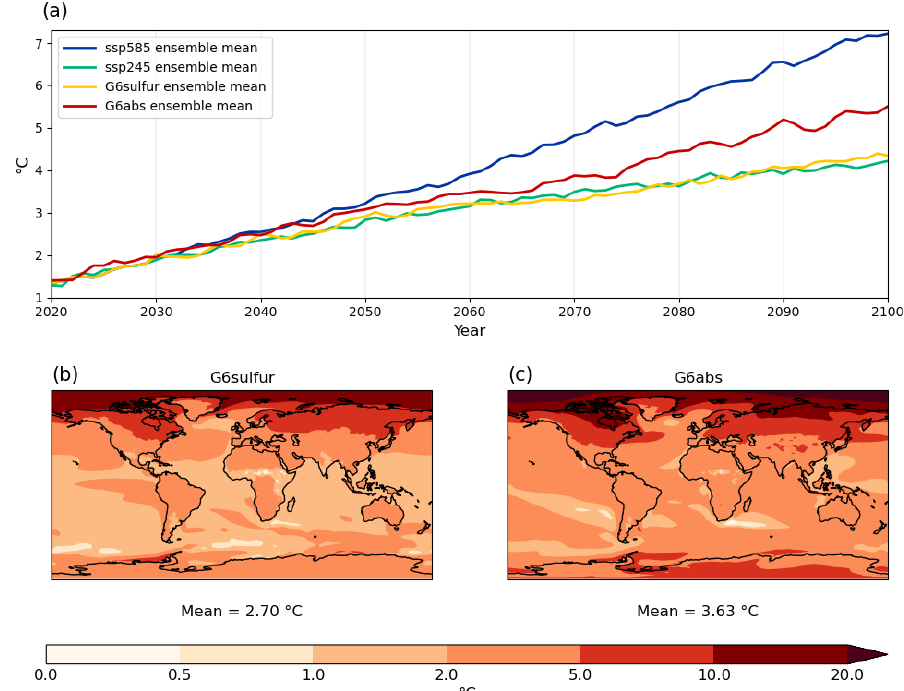
Figure 2. (a) The change in the global-mean near-surface air temperatures from pre-industrial (PI) conditions for (a) the SSP5–8.5 (ssp585), SSP2–4.55 (ssp245), G6sulfur and G6abs ensembles. Each ensemble is comprised of three members. The spatial distribution of the annual- mean surface temperature change for 2081–2100 compared to present day (PD) for (b) G6sulfur and (c) G6abs. All areas in (b) and (c) are significant at the 5% level using a two-tailed t